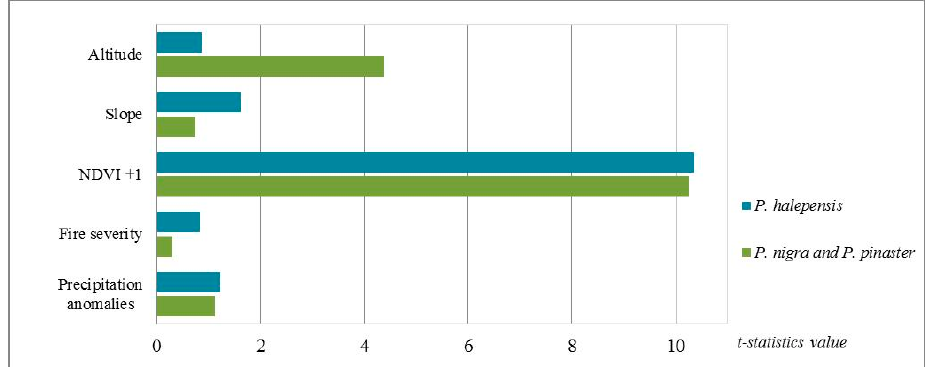
Figure 5. Relative importance of predictor variables according to the absolute value of the t-statistic.